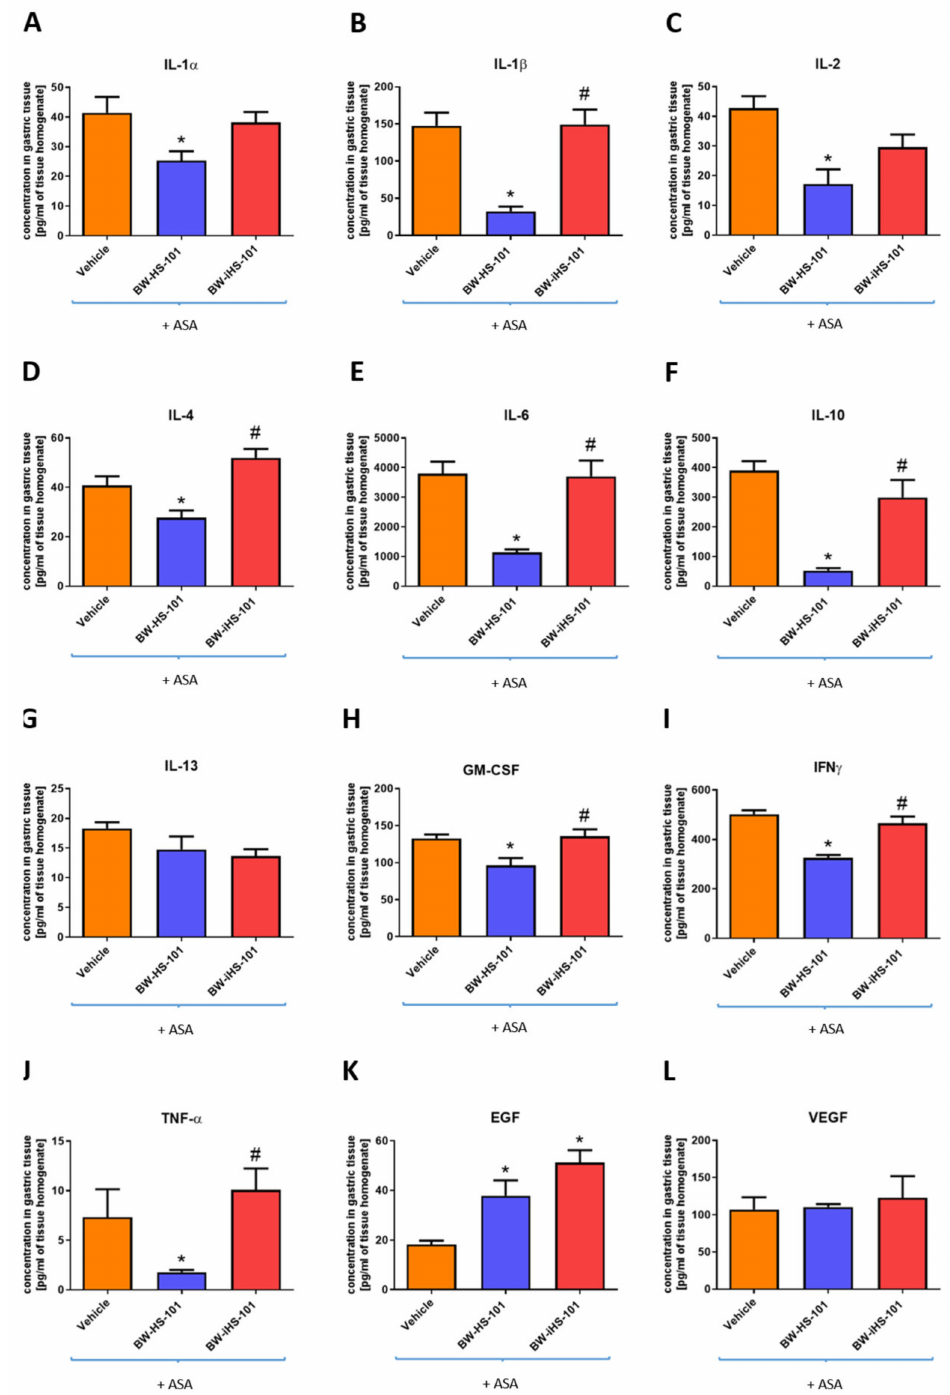
Figure 5. Concentration of interleukin (IL)-1 α ( A ), IL-1 β ( B ), IL-2 ( C ), IL-4 ( D ), IL-6 ( E ), IL-10 ( F ), IL-13 ( G ), granulocyte- macrophage colony-stimulating factor (GM-CSF) ( H ), interferon (IFN) γ ( I ), tumor necrosis factor (TNF)- α ( J ), epidermal growth factor (EGF) ( K ), or vascular endothelial growth factor (VEGF) ( L ) in gastric mucosa of rats administered i.g. with acetylsalicylic acid (ASA, 125 mg/kg) and pretreated 30 min earlier with vehicle, BW-HS-101 (50 µ mol/kg), BW-iHS-101 (50 µ mol/kg) or lactone (50 µ mol/kg). Results are mean ± SEM of five rats per each experimental group. Significant changes as compared with the respective values in vehicle-treated rats are indicated by asterisk (*) ( p < 0.05). Hash (#) indicates significant changes as compared with BW-HS-101 ( p <